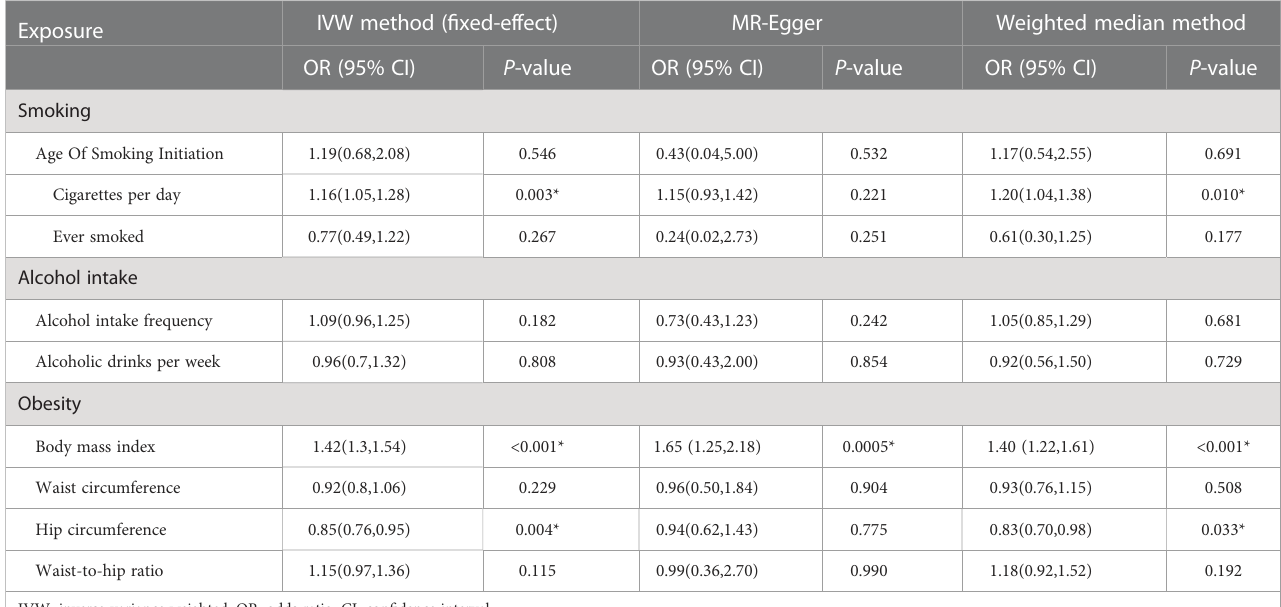
TABLE 2 Mendelian randomization estimates of the associations between unhealthy lifestyle and risk of DR.